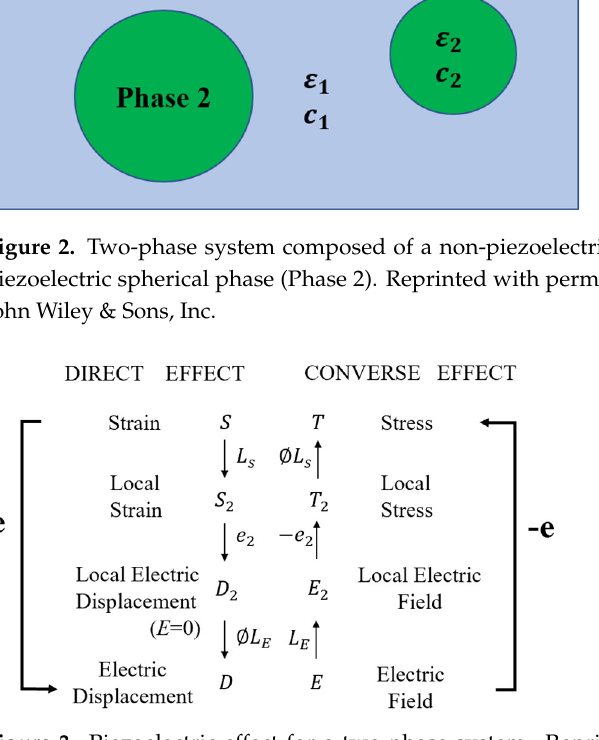
Figure 3. Piezoelectric effect for a two-phase system. Reprinted with permission from ref. [87]. Copyright 1973 John Wiley & Sons,